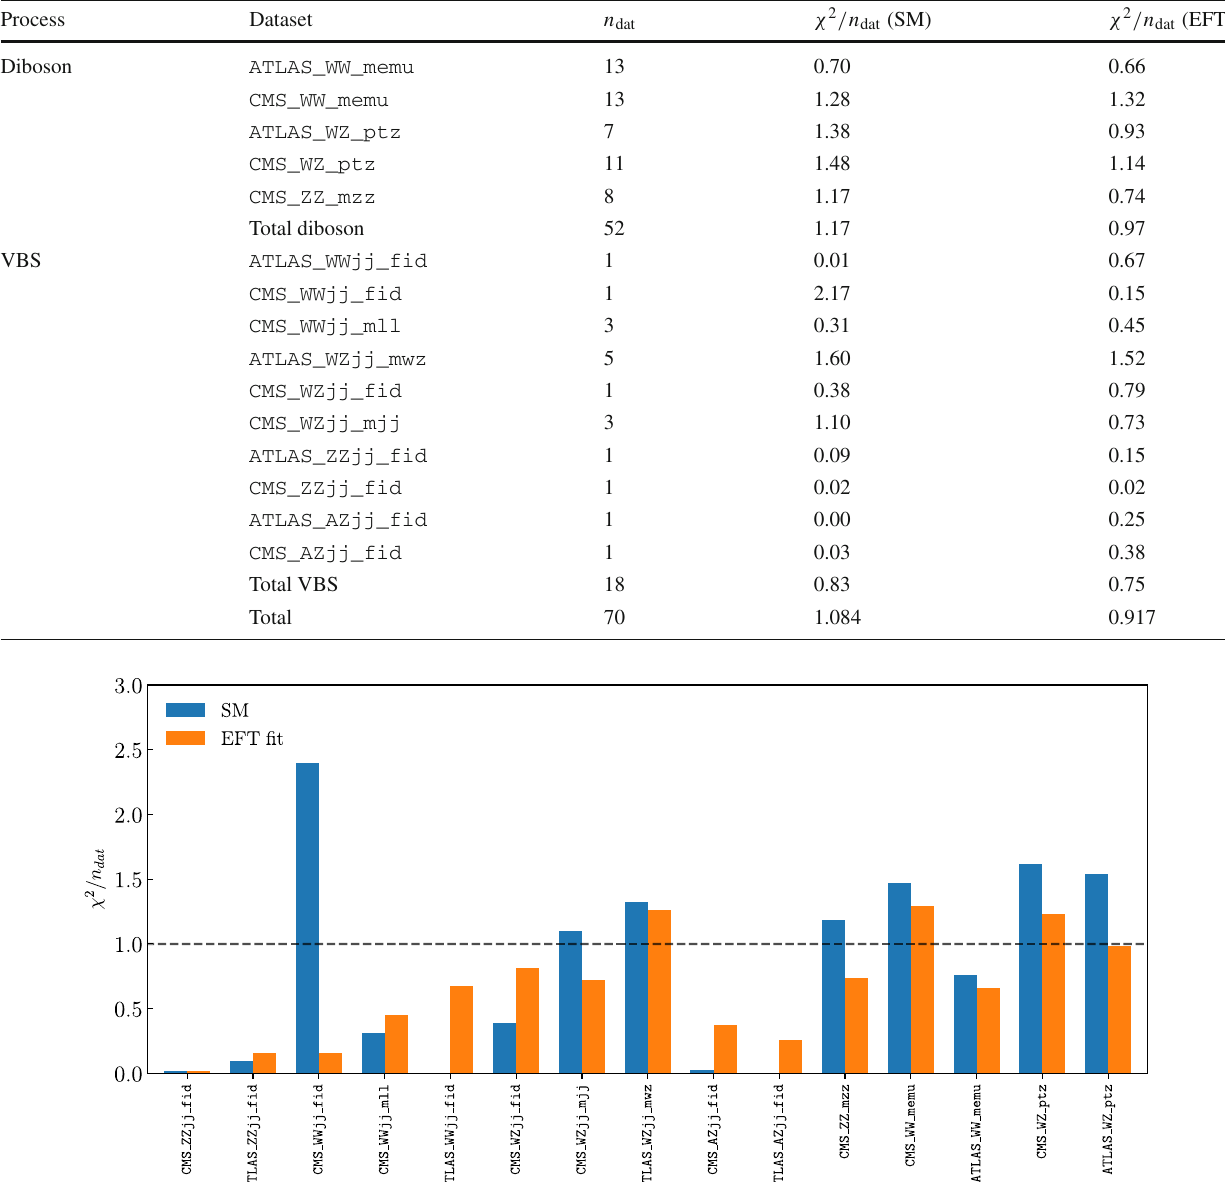
Table 8 The values of the χ 2 / n dat for each dataset considered in the fit, as well as the totals in each category. We indicate the SM (pre-fit) results as well as the best-fit results once EFT effects are accounted for, and separate the diboson (upper) from the VBS (bottom) datasets Process